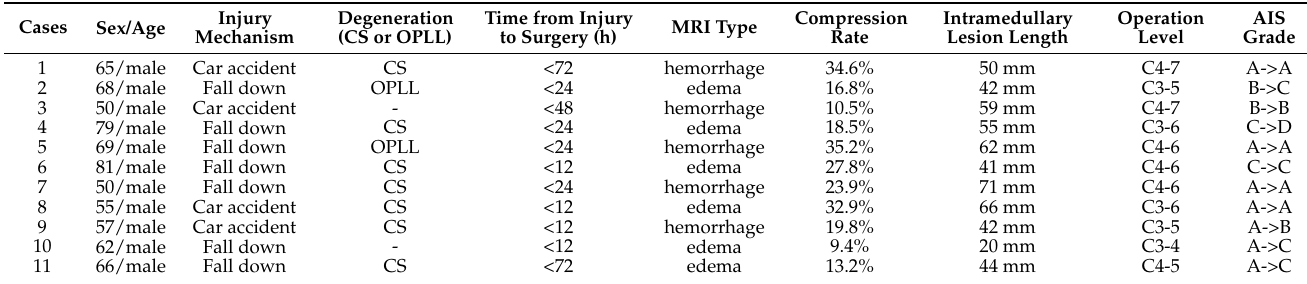
Table 1. Demographic and clinical data of adult spinal cord injury without major bone injury patients.